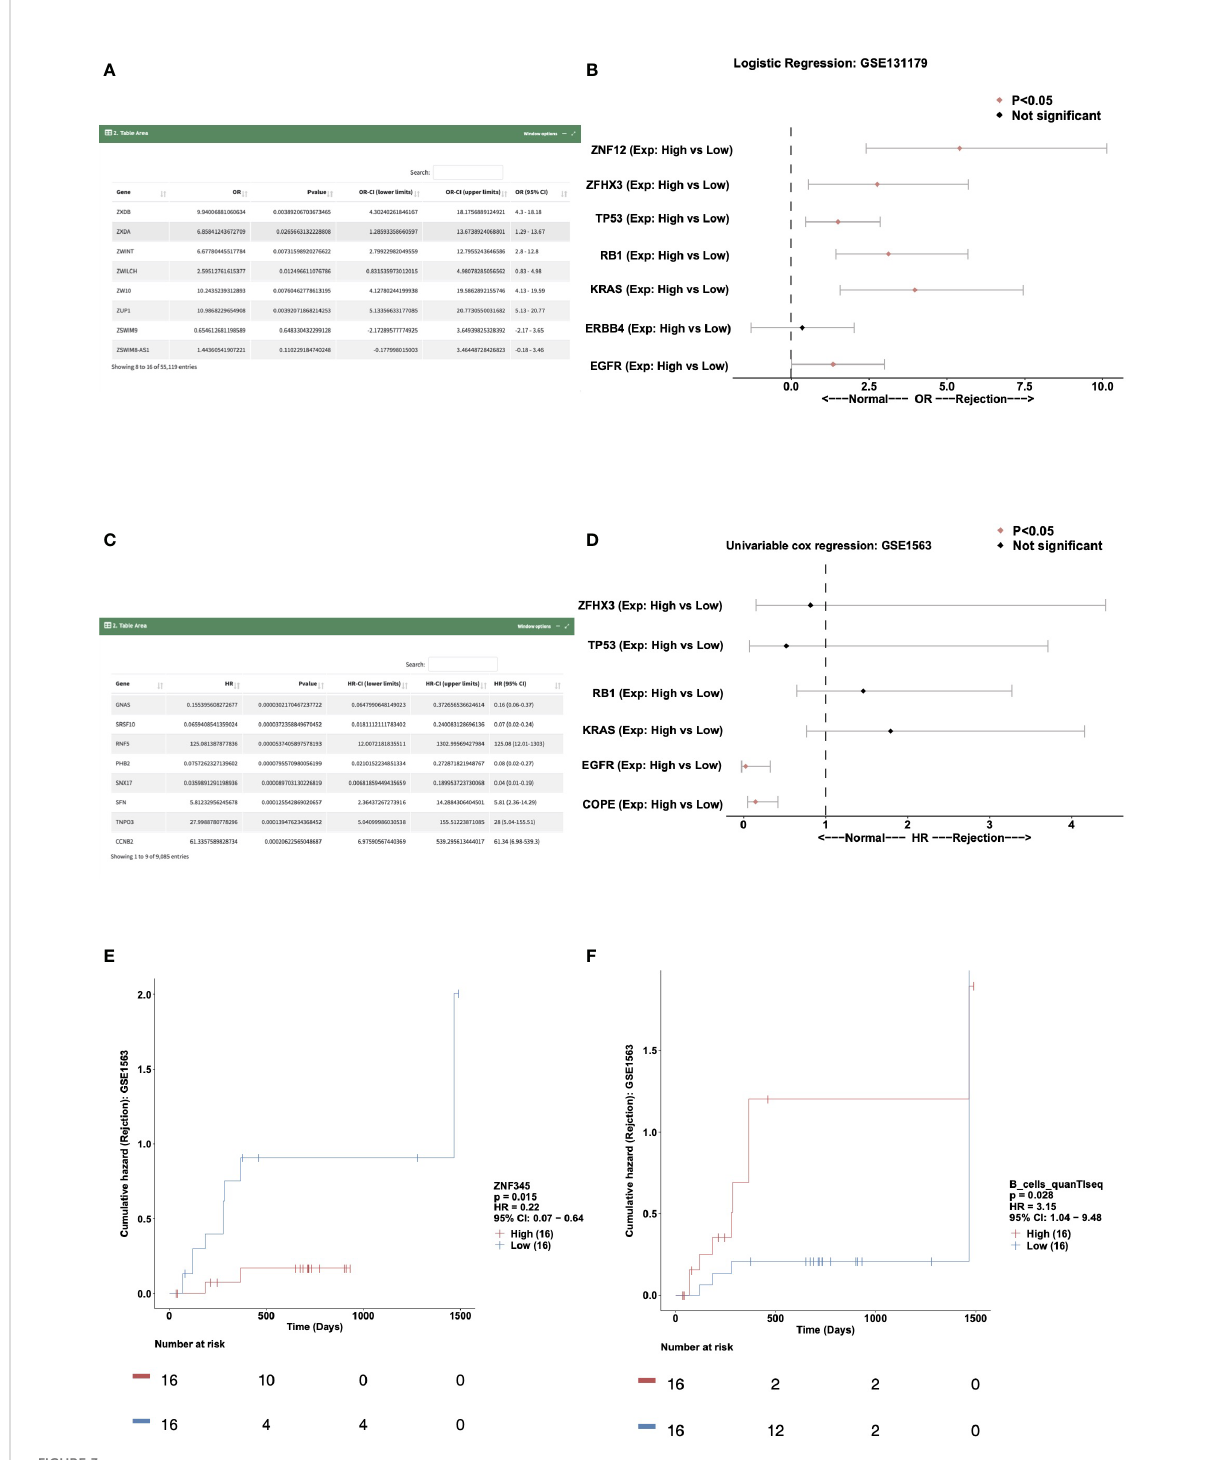
FIGURE 3 Example of the “ Prognosis Analysis ” tab. (A) Data table showing the result of the logistics regression model in cohort GSE131179. (B) Forest plot showing the OR and P value of the gene expressions for ZNF12, ZFHX3, TP53, RB1, KRAS, ERBB4, and EGFR in the GSE131179 cohort. (C) Data table showing the result of the univariable cox regression model in cohort GSE131179. (D) Forest plot showing the HR and P value of the gene expressions for ZFHX3, TP53, RB1, KRAS, EGFR, and COPE in the GSE131179 cohort. (E, F) . Survival characteristics of the patients included in the database, including gene expressions (E) and immune cells scores (F)